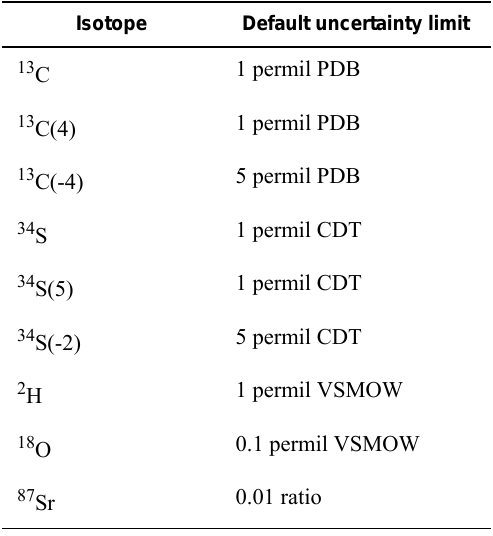
Table 4. Default uncertainty limits for